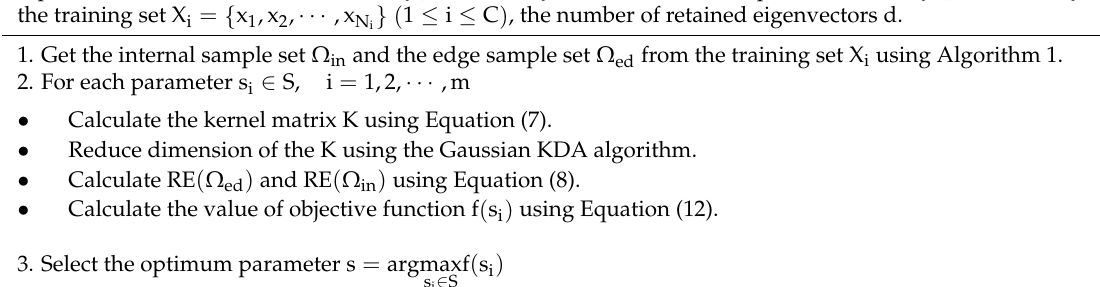
Table 5. The Method for Selecting the Gaussian KDA Parameter.